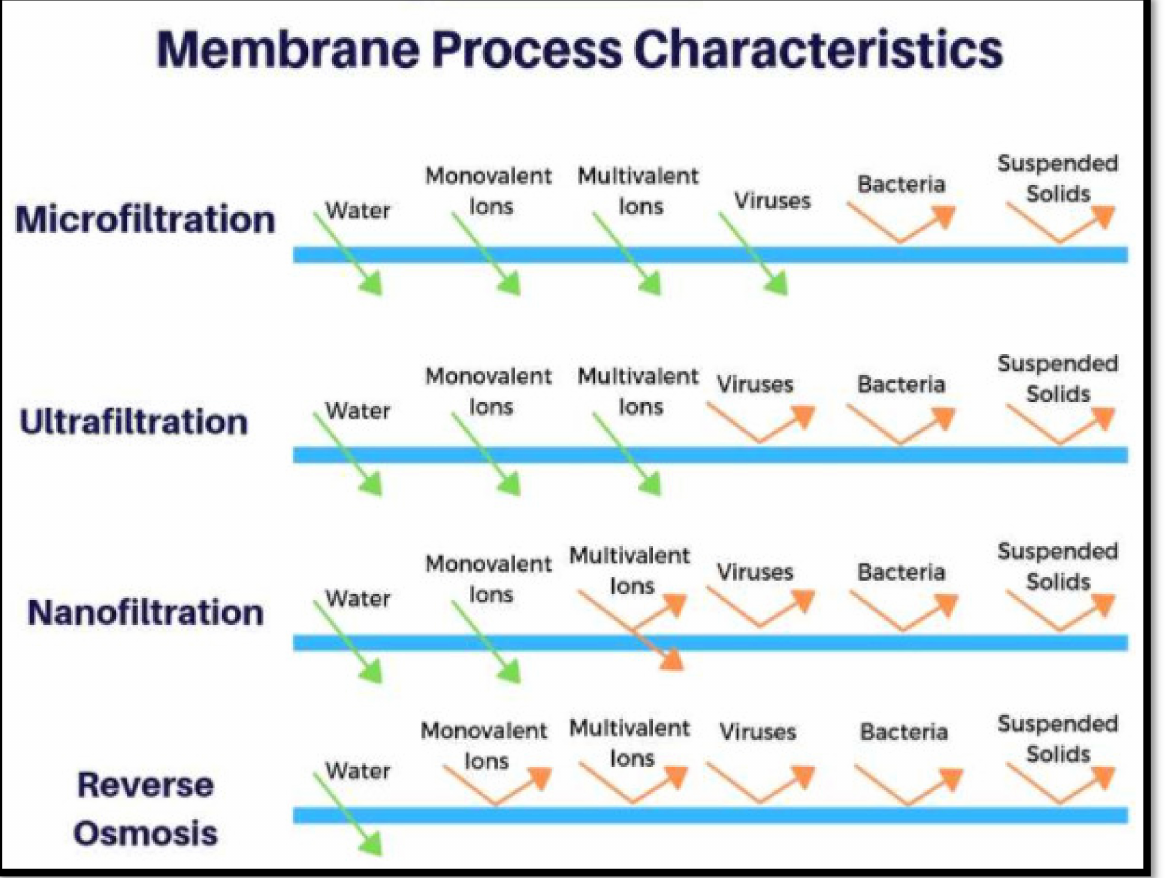
Figure 10. Comparison of membrane process